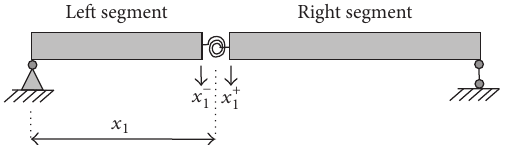
Figure 2: Crack model of the beam.